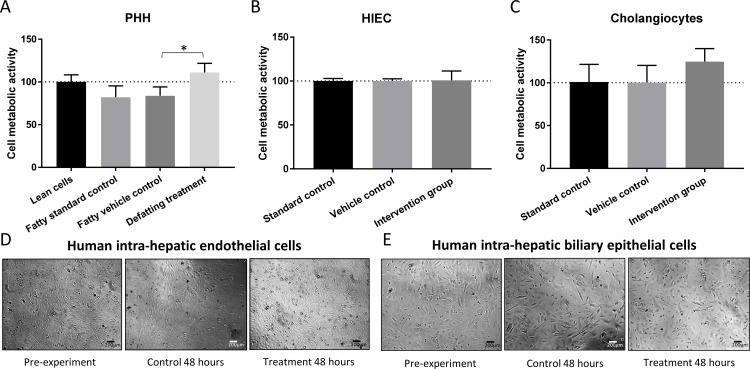
Assessment of the cytotoxicity of the defatting cocktail to human cells of the liver via MTT assay.Panel A: the toxicity of the defatting cocktail was tested in primary human hepatocytes and results showed a significant improvement of 11% in viability of the defatting treatment group compared with the fatty vehicle control group. Panel B: Treatment of human intra-hepatic endothelial cells (HIEC) with the drugs had no effect on cell viability compared with the control groups. Panel C: treatment of cholangiocytes with the defatting cocktail did not demonstrate any cytotoxic effect to the cells and indicated a slight improvement in viability compared to the control groups. Panels D and E: Phase contrast microscopy showing representative images of HIEC (Panel D) and cholangiocytes (Panel E) at different time points. No gross modifications in cell integrity were observed in either cell type which was consistent and supportive of the MTT data. Data report the median of three separate experiments performed in quadruplicate and errors bars the interquartile range. Comparisons performed using two-tailed t-test. * = p<0.05.